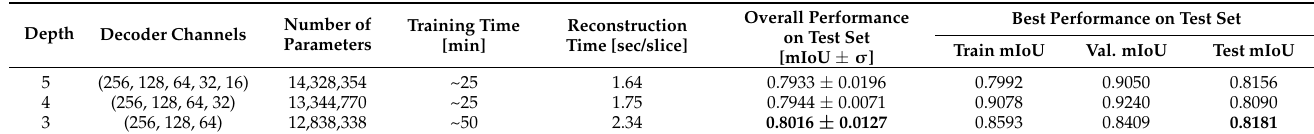
Table 2. U-Net segmentation performance at different levels.